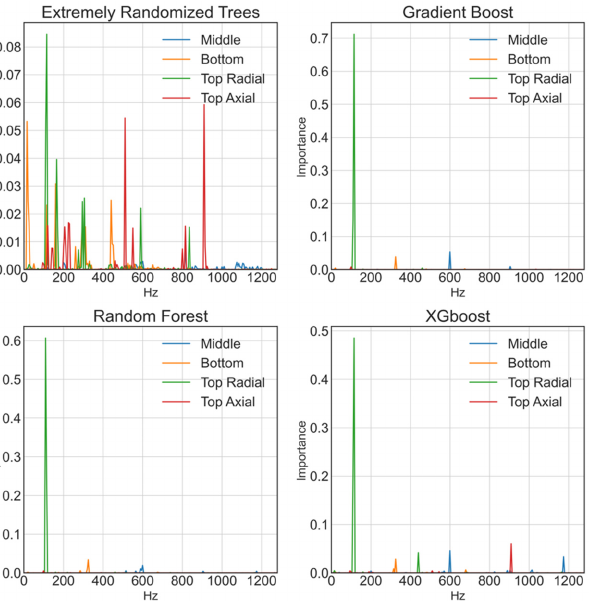
Figure 11. Trial 1 ′ s Gini importance of the 20 times average of using four different regressors using optimal RAE settings, with T RUL = 70